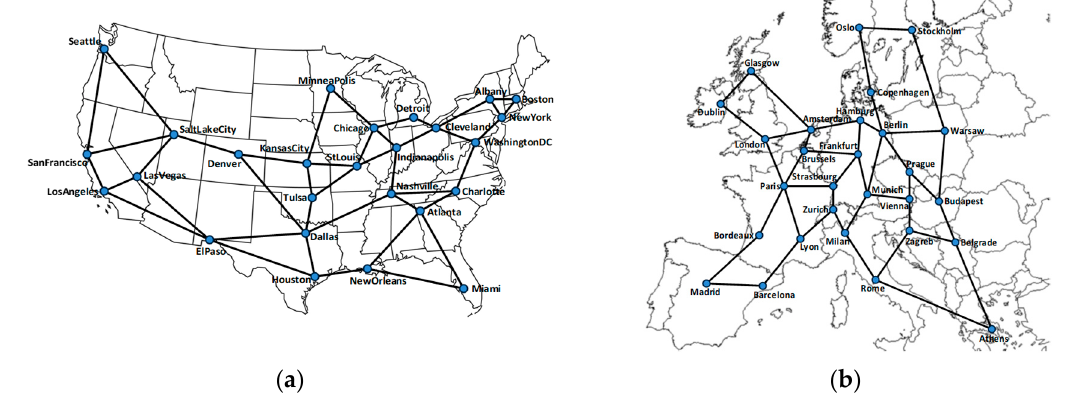
Figure 5. Tested network topologies: US26 ( a ), Euro28 ( b ).